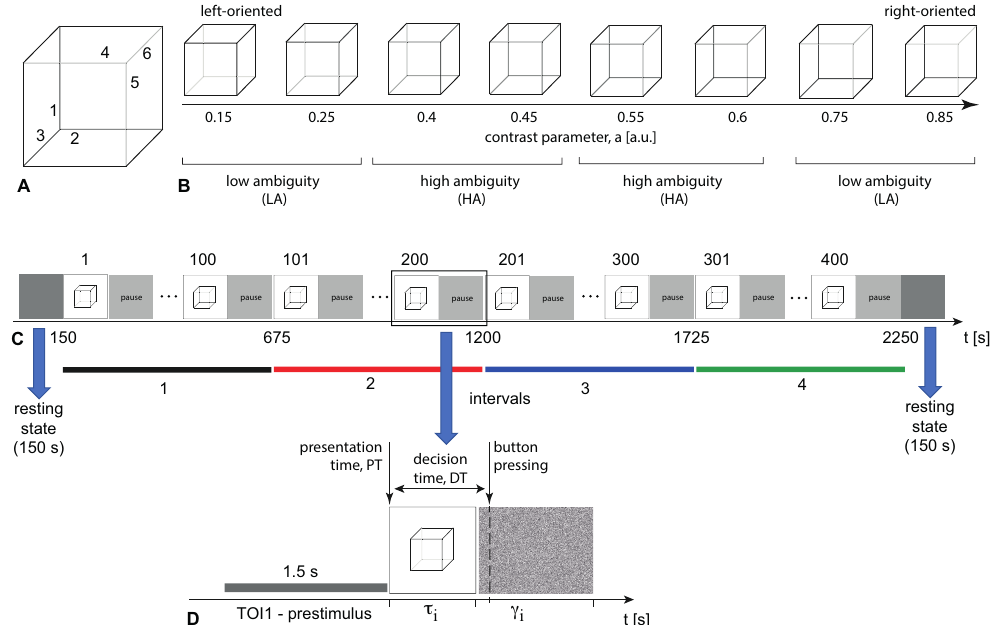
Figure 1. Experimental paradigm: ( A ) An example of the Necker cube image with the labeled inner edges. ( B ) Visual stimuli (Necker cubes) with different values of the contrast parameter a , which determines orientation and ambiguity. ( C ) Experimental protocol including 150-s resting state recordings and presentation of 400 stimuli alternating with the pauses. Colored horizontal stripes indicate 575-s time intervals. These intervals equally divide the stimuli presentation session. Each interval includes 100 stimuli. ( D ) Detailed illustration of a single stimulus presentation and abstract image. The cube presentation starts at the presentation time PT and lasts τ i ∈ [ 1, 1.5 ] s. The decision time (DT) is determined by the interval between PT and button pressing. The pause time γ i varies from 3 to 5 s. The time interval of interest (TOI1) is the 1.5-s pre-stimulus segment time-locked to the